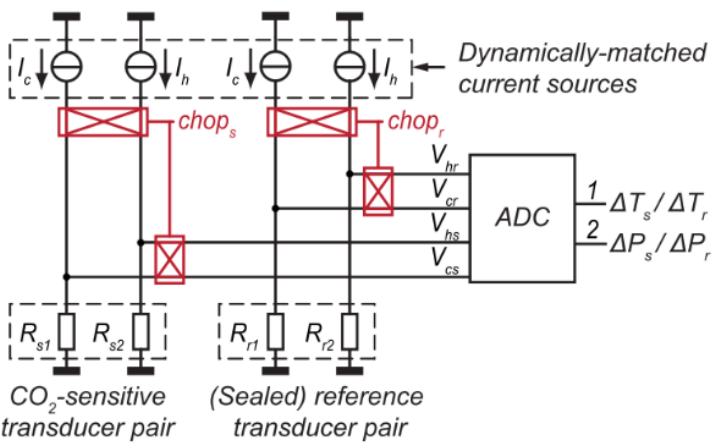
Figure 13. Block diagram of the ratiometric thermal conductivity sensor readout with transducer pairs for baseline-resistance cancellation used in [111]. pairs for baseline-resistance cancellation used in